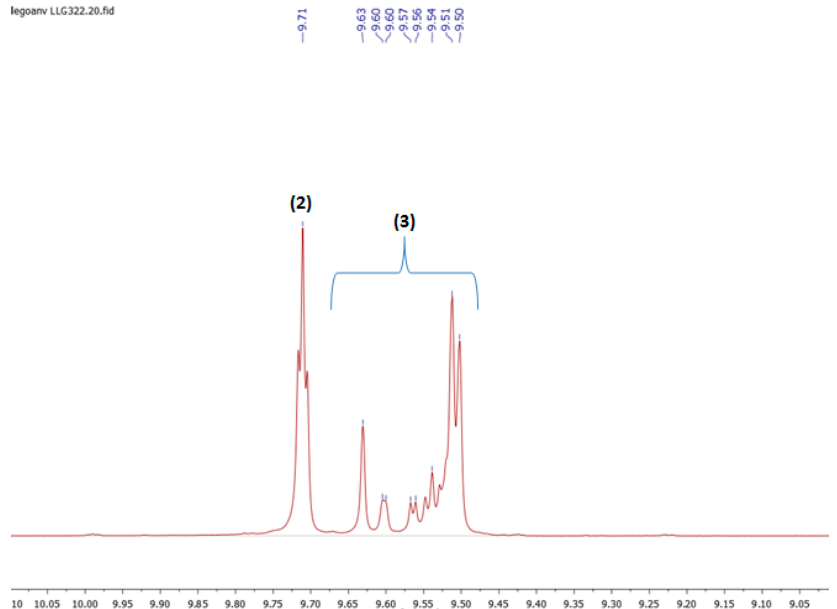
Figure A3. Detail of the aldehyde region of the 1 H NMR spectrum (400 MHz, CDCl 3 , 298 K) of a typical final mixture in the hydroformylation of oleonitrile (Table 2, entry 8).